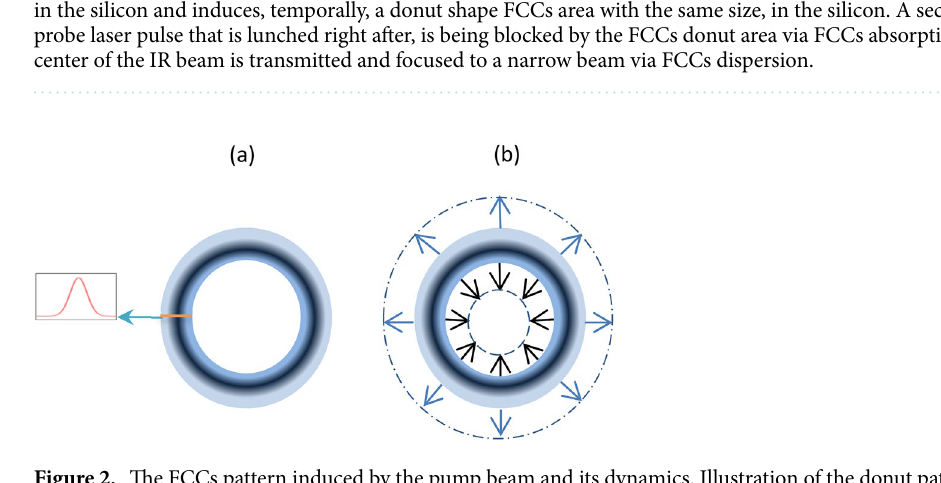
Figure 2. The FCCs pattern induced by the pump beam and its dynamics. Illustration of the donut pattern of the FCCs that is excited by the donut shaped pump beam on the silicon is shown in ( a ), in the insert we show the Gaussian distribution of FCCs density across the donut. In ( b ) we show the diffusion directions of the FCCs; out of the donut (blue arrows), the part of the probe beam that is outside the donut will defocus while toward the donut’s center (black arrows) a focusing will occur for the part of the probe beam enclosed in the inner part of the donut. The optical axis is perpendicular to the